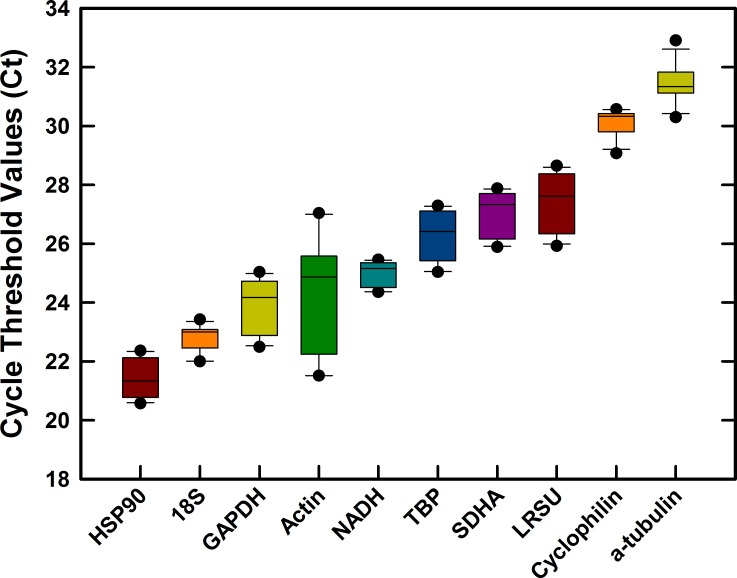
Stabilities of cycle threshold (Cq) values of ten candidate reference genes in Varroa destructor.The box plot with medians indicates the 25th and 75th percentiles and the whiskers (error bars) indicate the 10th and 90th percentiles. Black dots represent outliers. Data for each gene from 3 replicates of each grouping (brood, phoretic, Low Virus and High Virus), each sample contained 8 varroa.